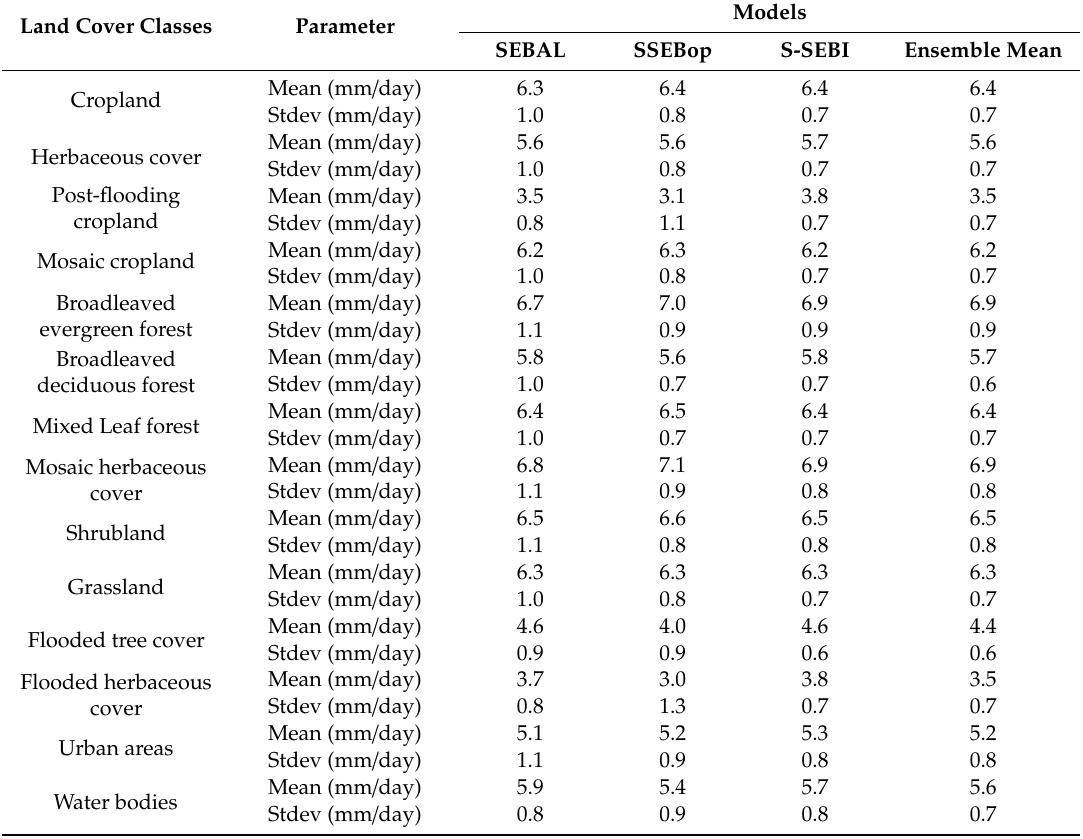
Table 7. The descriptive statistics derived from the daily evapotranspiration estimates computed using the Surface Energy Balance (SEB) model (for total 25 MODIS satellite overpasses) for di ff erent land cover classes in the Kilombero Valley river basin. SEBAL, Surface Energy Balance Algorithm for Land; SSEBop, Operational Simplified Surface Energy Balance Algorithm; S-SEBI, Simplified Surface Energy Balance Index, Ensemble mean, the mean of daily ET estimates from the three models (SEBAL, SSEBop, and S-SEBI); Stdev, sample standard